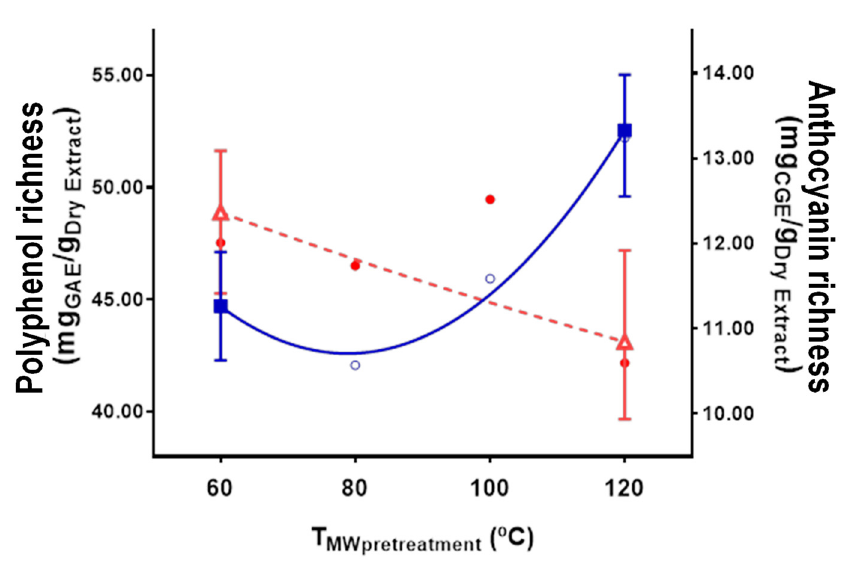
Figure 6. Polyphenol ( ■ ) and anthocyanin ( ∆ ) richness in the extraction with microwave pretreatment at 0.30 g/mL S:L ratio ( ○ polyphenol and ● anthocyanin experimental points).